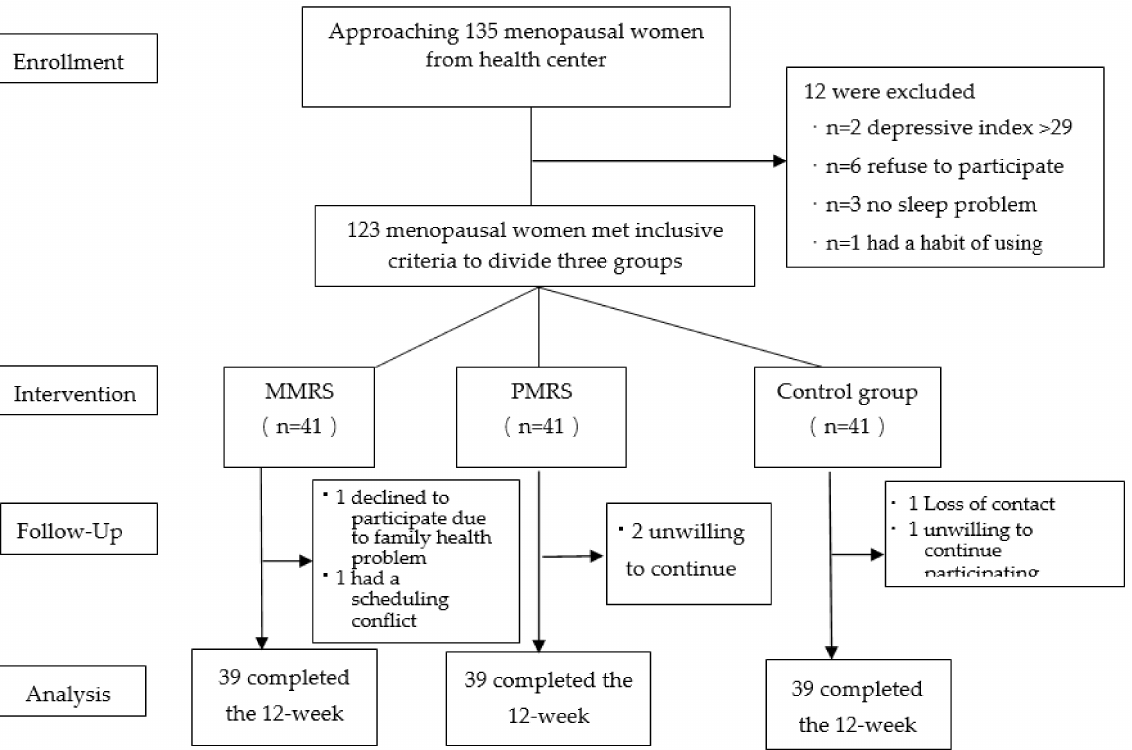
Figure 1. The flowchart of study enrollment, participation, intervention, and analysis